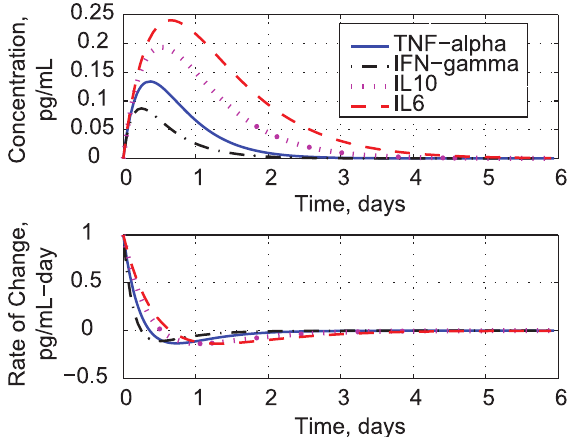
Figure 2. Response to unit initial rates of change for TNF- a , IFN- c , IL10, and IL6.